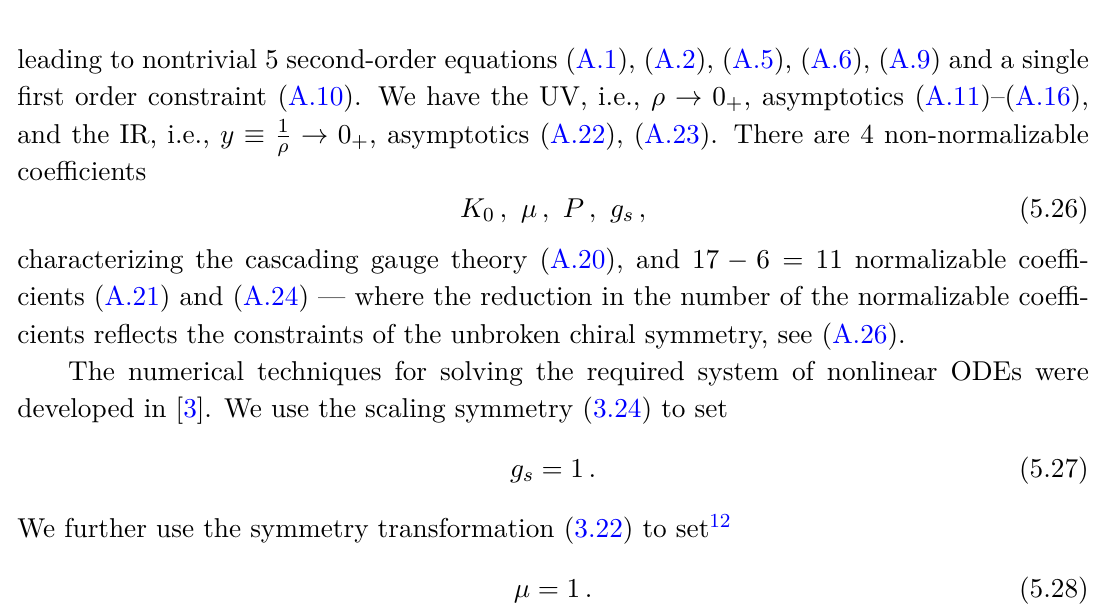
Figure 11 . Cross checks on numerics of schemes: solid blue curve and the dotted magenta curve. The vertical blue line denotes the common reference point in the two computational schemes, see